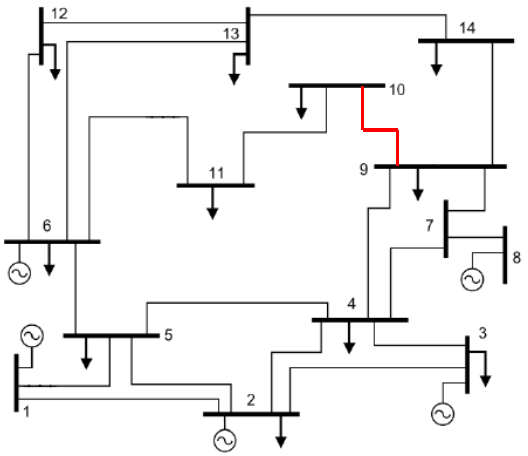
Figure 2. IEEE 14 bus system where the critical line (line 9-10) is disconnected due to any outages.